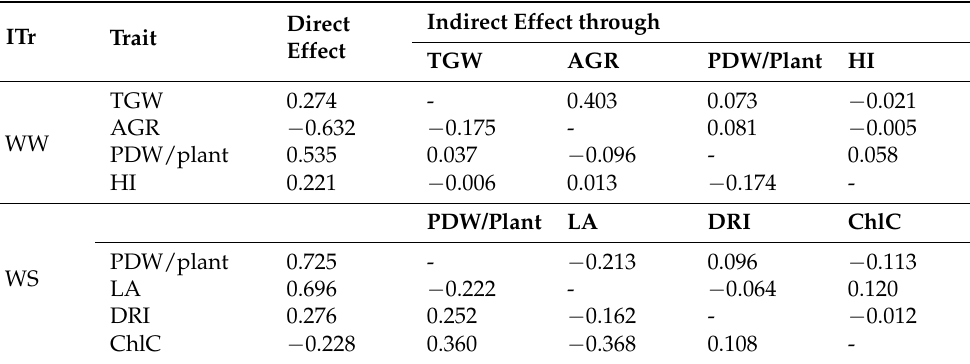
Table 3. Direct and indirect effects of factors influencing grain yield in foxtail millet under two irrigation treatments for five seasons.